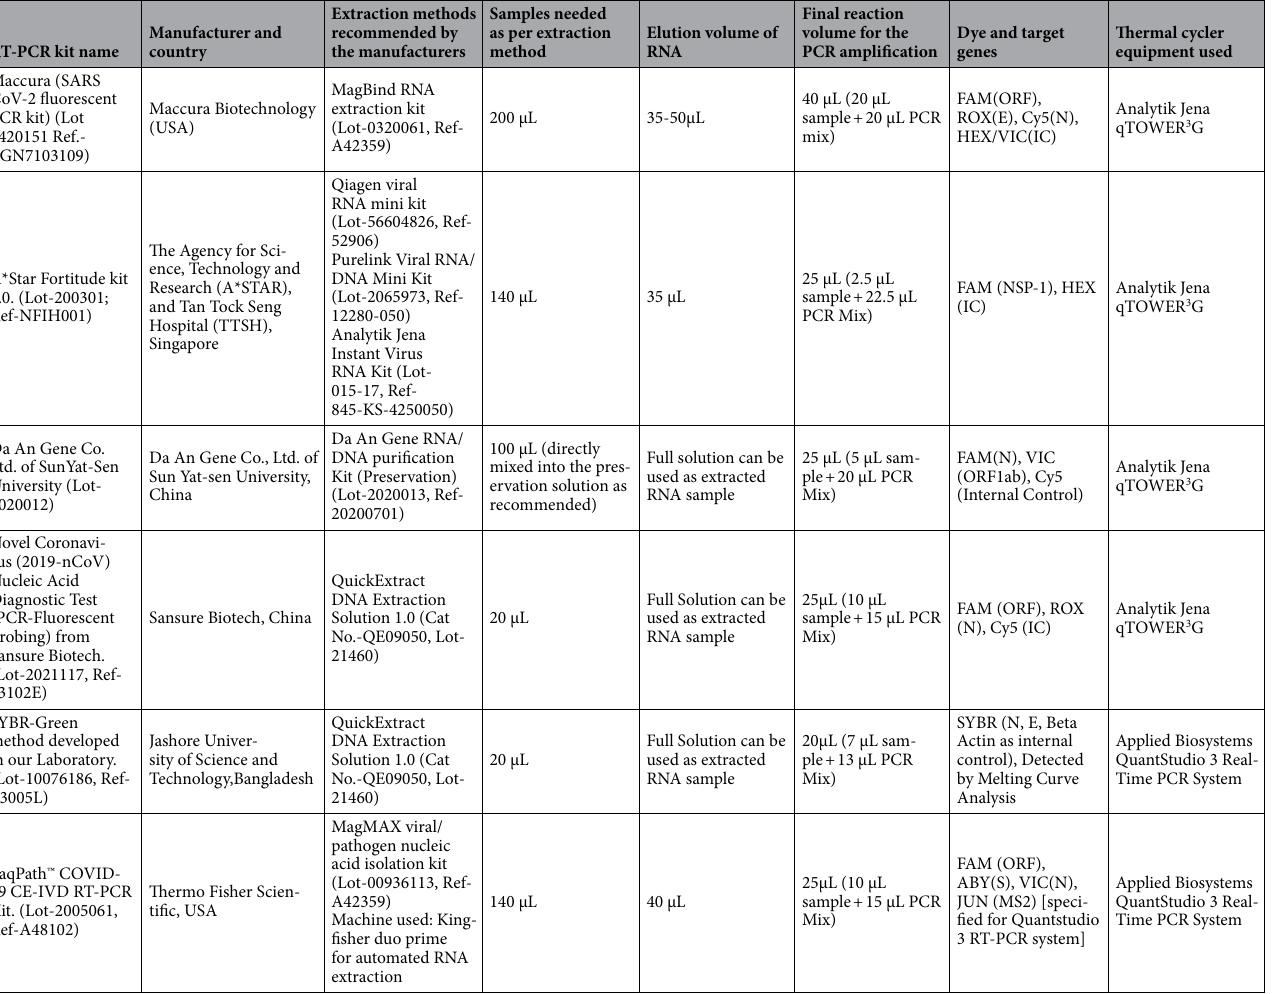
Table 3. The basic information and technique index of selected RT-PCR Kits; RT-PCR real-time polymerase chain